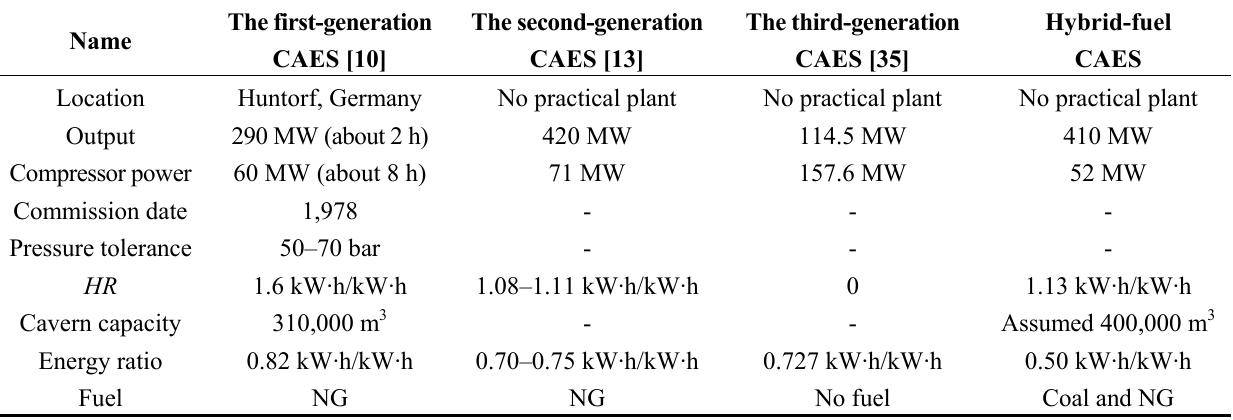
Table 4. Comparisons of the main parameters of hybrid-fuel CAES and other CAES